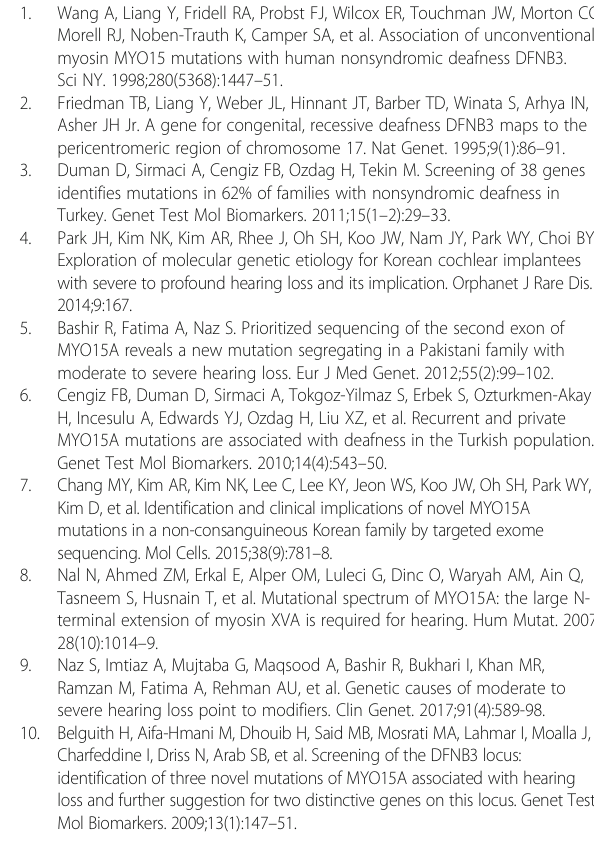
Additional file 1: Table S1. List of known 129 deafness genes targeted in this study. (DOCX 46 kb) Additional file 2: Table S2. Depth of coverage of customized panel sequencing. The table enumerates the mean coverage of the targeted regions from customized panel sequencing sample calculated by mpileup of samtools. (DOCX 206 kb) Additional file 3: Table S3. Exome sequencing statistics. The table lists information of human genome reference (v19), customized panel and whole exome sequencing aligned reads from each patient estimated by CalculateHsMetrics of picard tool. (DOCX 29 kb) Abbreviations 1000G: 1000 Genomes Project; CNV: Copy number variation; EAS: Electroacoustic stimulation; ESP6500: Exome Sequencing Project 6500; ExAC: Exome Aggregation Consortium; GO-ESP: Grand Opportunity Exome Sequencing Project; KRGDB: Korean Reference Genome Database; MAF: